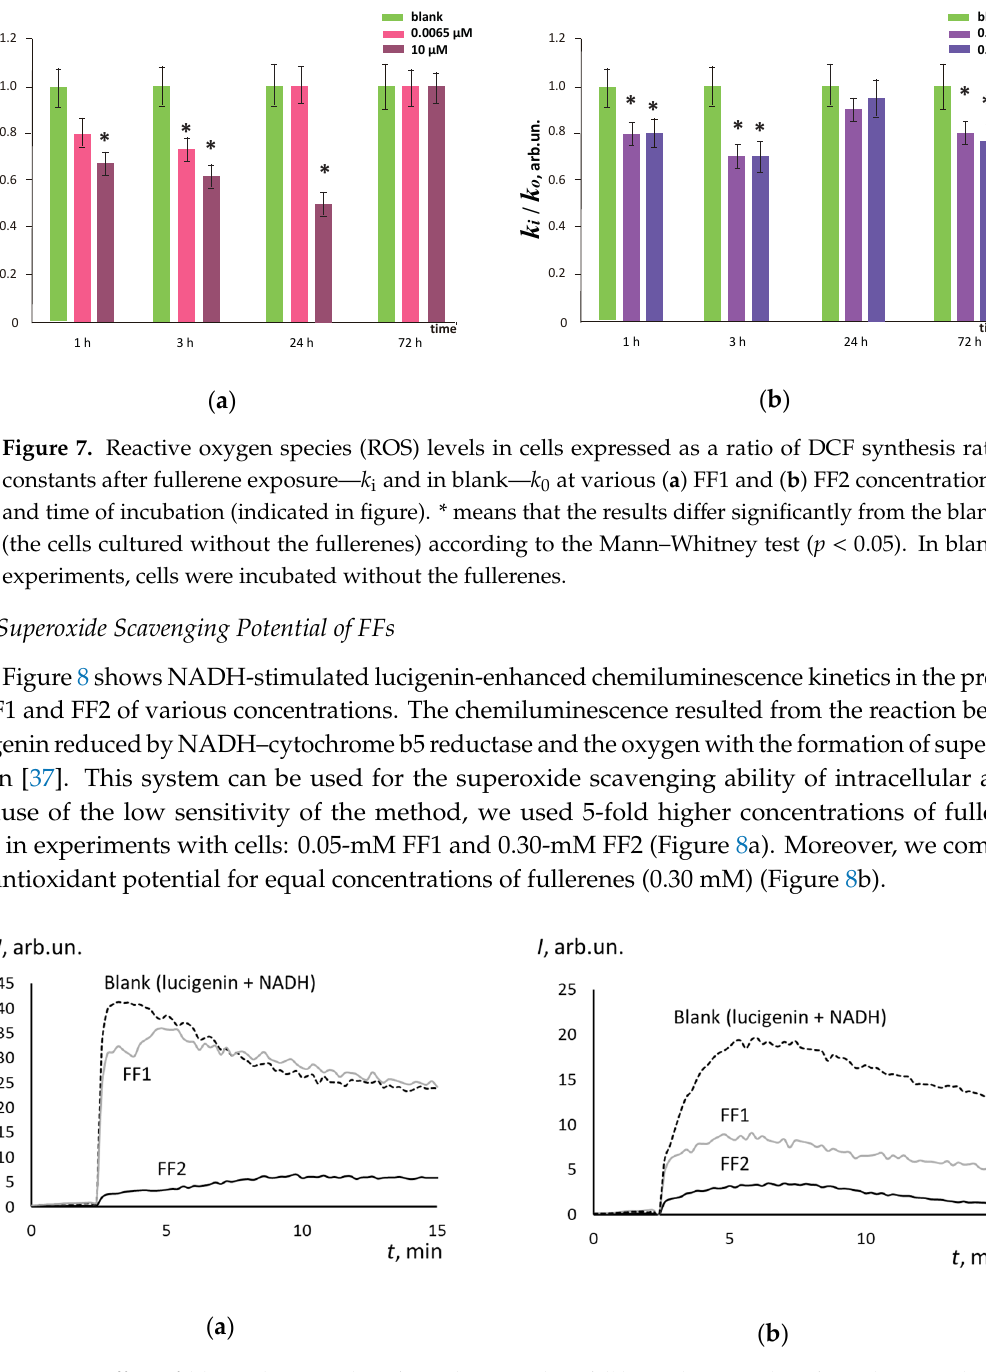
Figure 8. Effect of ( a ) FF1 (0.05 mM) and FF2 (0.30 mM) and ( b ) FF1 (0.30 mM) and FF2 (0.30 mM) on lucigenin-enhanced (0.40 mM) chemiluminescence in the presence of NADH (0.8 mM).